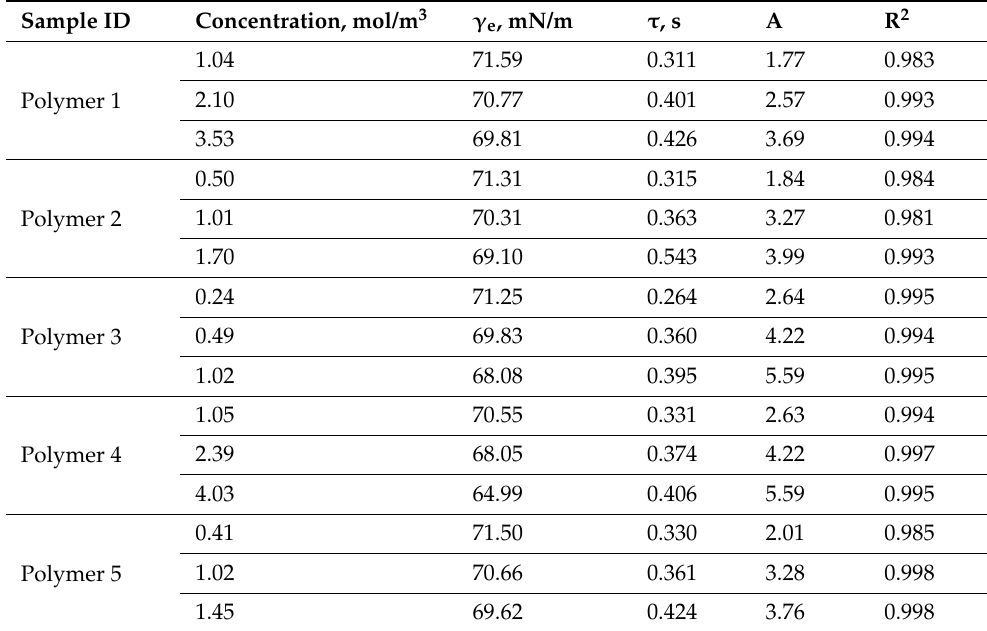
Table 5. Relaxation time ( τ k ) for the CUP particles of polymer 1–5 at different